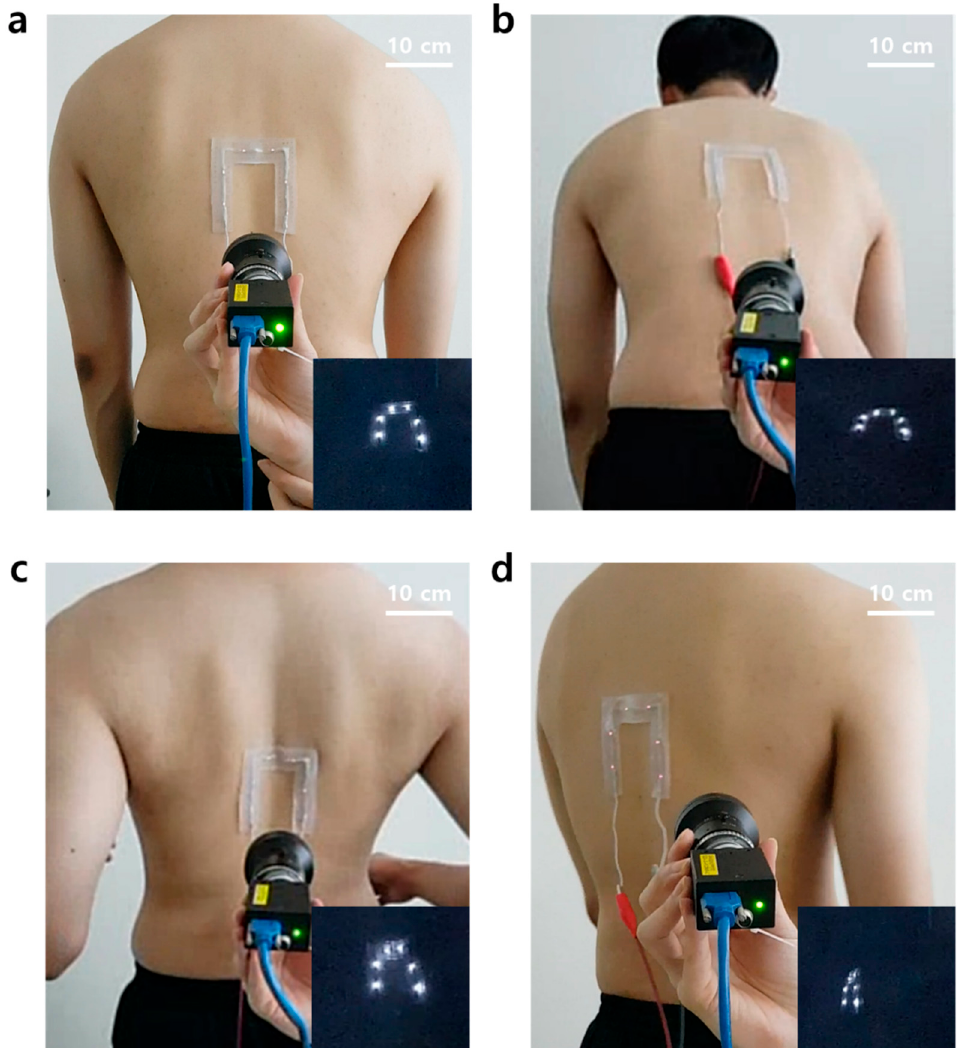
Figure 6. Skin-conformal adhesion demonstrations of the patch. ( a ) Standing straight. ( b ) Bending the waist forward. ( c ) Pulling two arms to the back. ( d ) Twisting the waist.